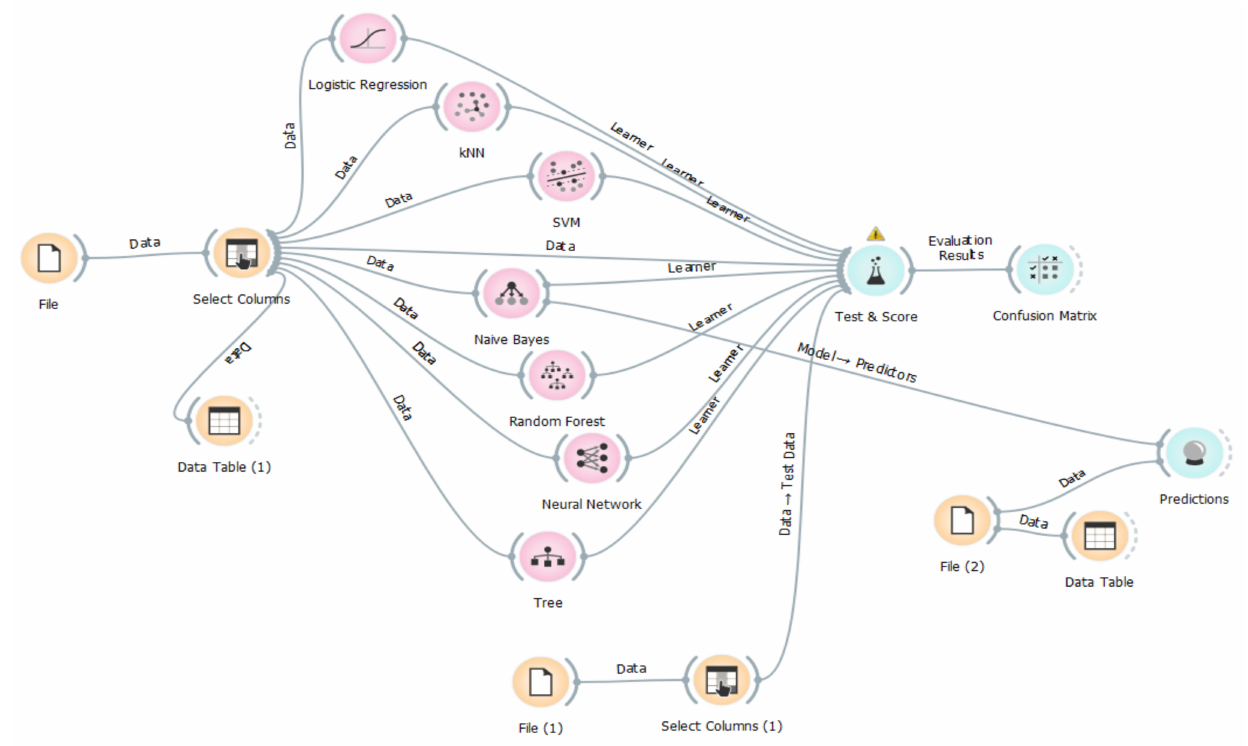
Figure 17. Prediction model for target types of operation data.